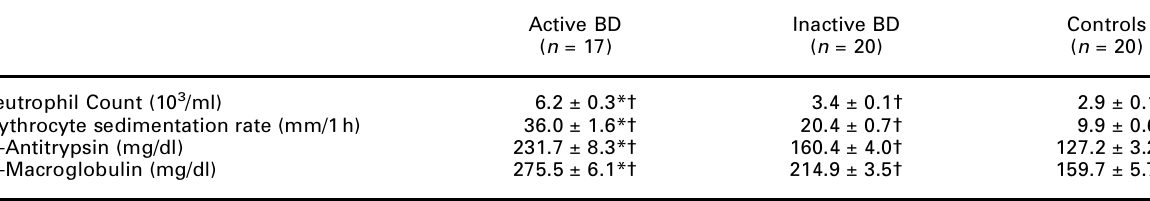
Table 3. Neutrophil count, erythrocyte sedimentation rate and acute-phase reactant levels in patients with active or inactive Behçet’s disease compared with control